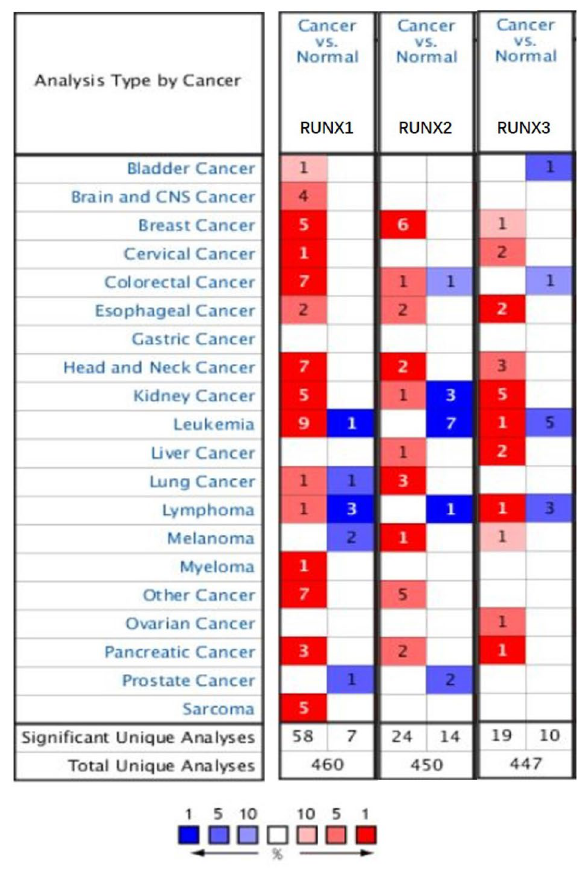
Figure 1. Oncomine analysis of the mRNA expression levels of RUNX genes in different cancers. The differences in expression levels of genes between cancer and normal tissues are concluded. The thresholds ( p -value < 0.01, fold change > 2; gene rank < 10%; data type: mRNA) are indicated in the colored cells. Red cells represent overexpression of the target gene in tumor tissues compared to normal tissues, while blue cells indicate downregulation of the gene. Gene rank is depicted by the color depth in the cells.